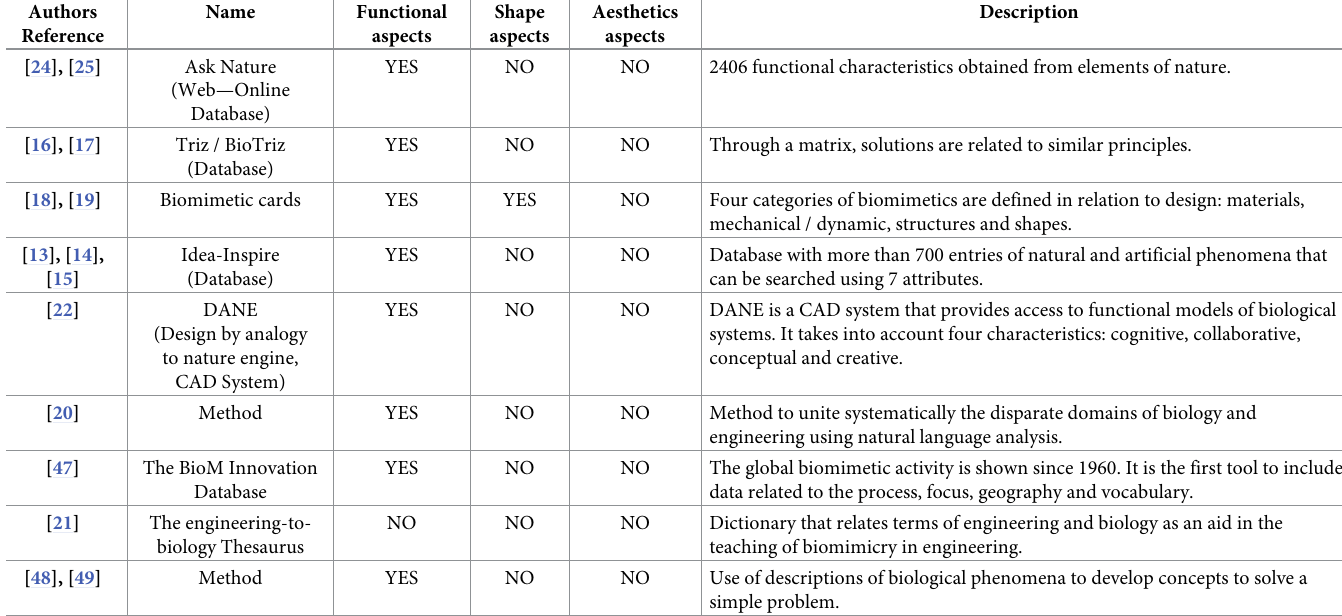
Table 1. Comparison of some current toolys to support bio-inspired